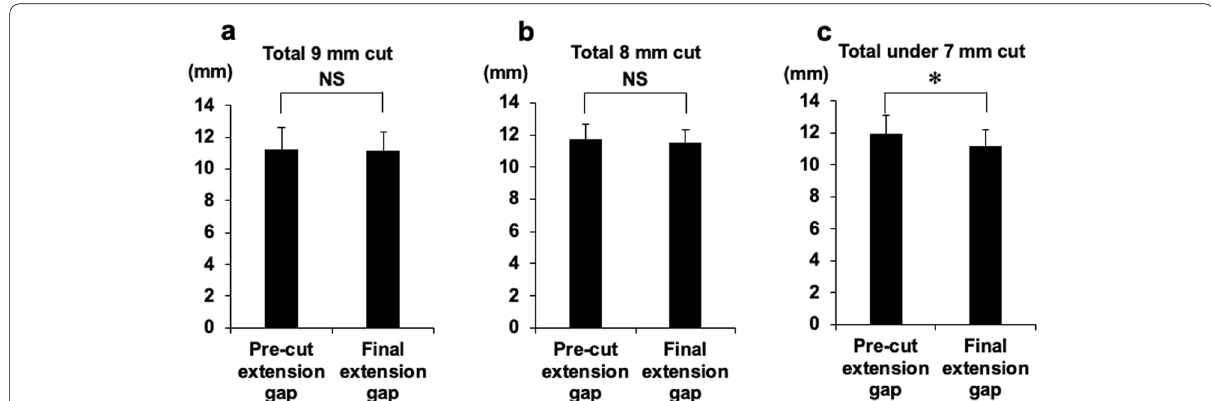
Fig. 6 Relationship between gap control size and the final CGs at knee extension. The final CGs after gap control 0 mm posterior to the cutting level (total 9 mm cut) ( a ), the final CGs after gap control 1 mm posterior to the cutting level (total 8 mm cut) ( b ) and final CGs after gap control 2 and 3 mm posterior to the cutting level (total under 7 mm cut) ( c ) were compared with the CGs with PS PCT at knee extension. (* P < 0.01). CG, component gap; PS PCT, posterior-stabilised pre-cut trial